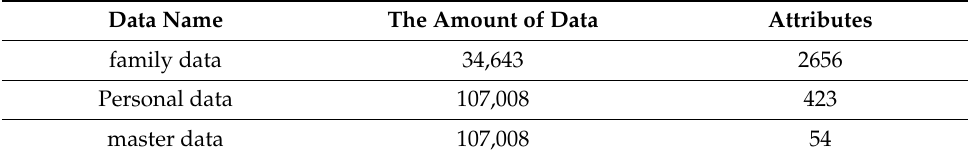
Table 10. China household finance survey data details from 2019.